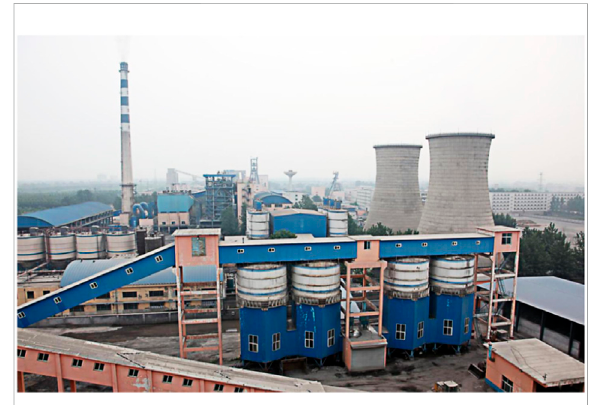
FIGURE 6 Diagram showing the physical effects of a back fi ll plant.